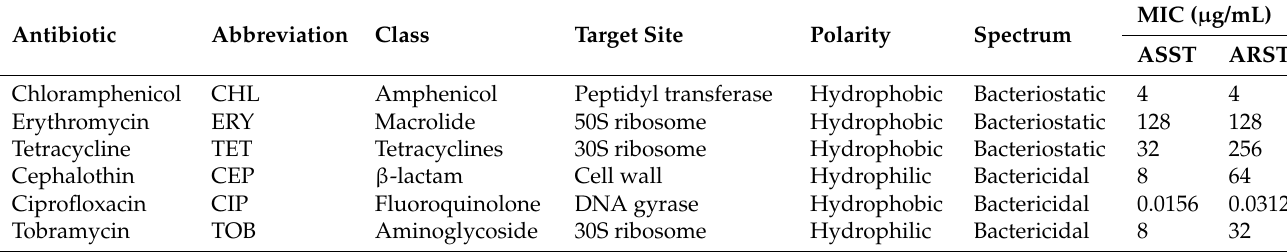
Table 1. Characteristics of antibiotics used in this